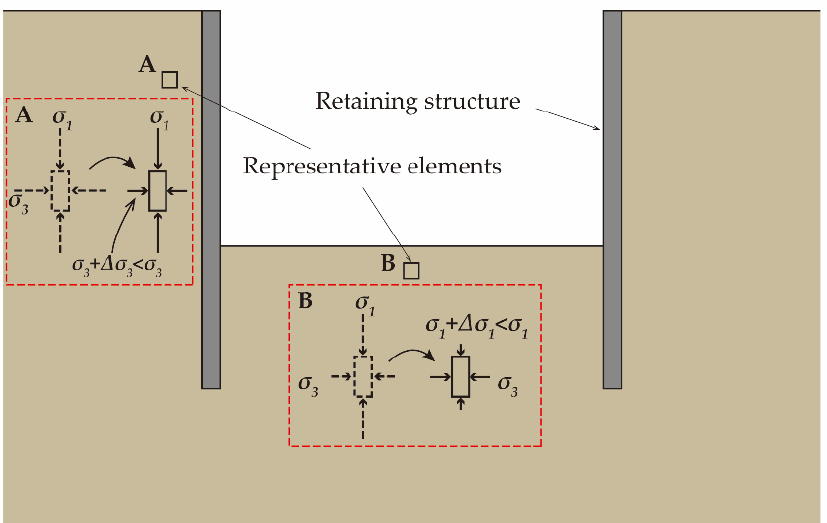
Figure 1. Stress paths involved during excavation of a foundation pit.